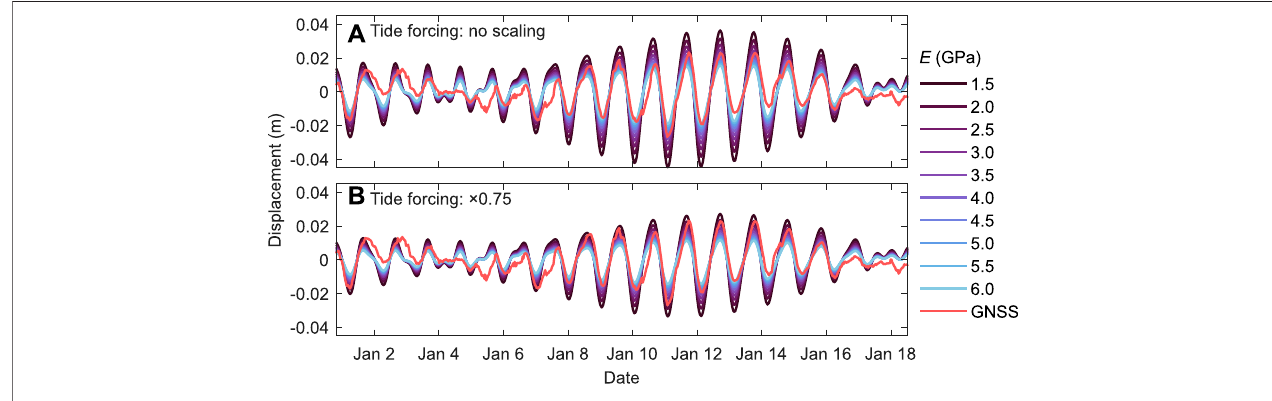
FIGURE7| Modelled versusGNSS – observedhorizontal(across- fl ow)displacement. In (A) , noscaling is applied tothe tideprediction. In (B) ,the ice fl exure model is forced by the CATS2008 tide prediction, scaled by ×0.75 to account for our proximity to the grounding line and glacier margin.